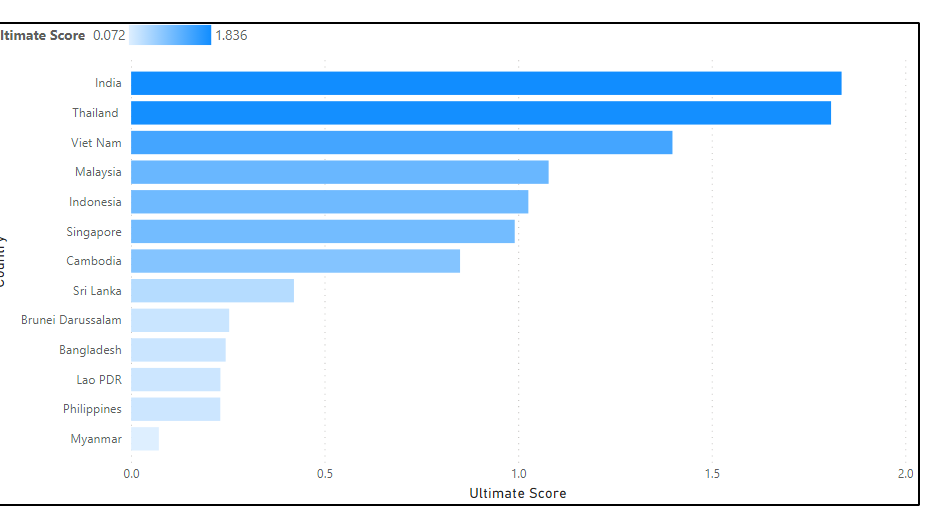
Figure 6. The ultimate score for moving high-tech manufacturing.